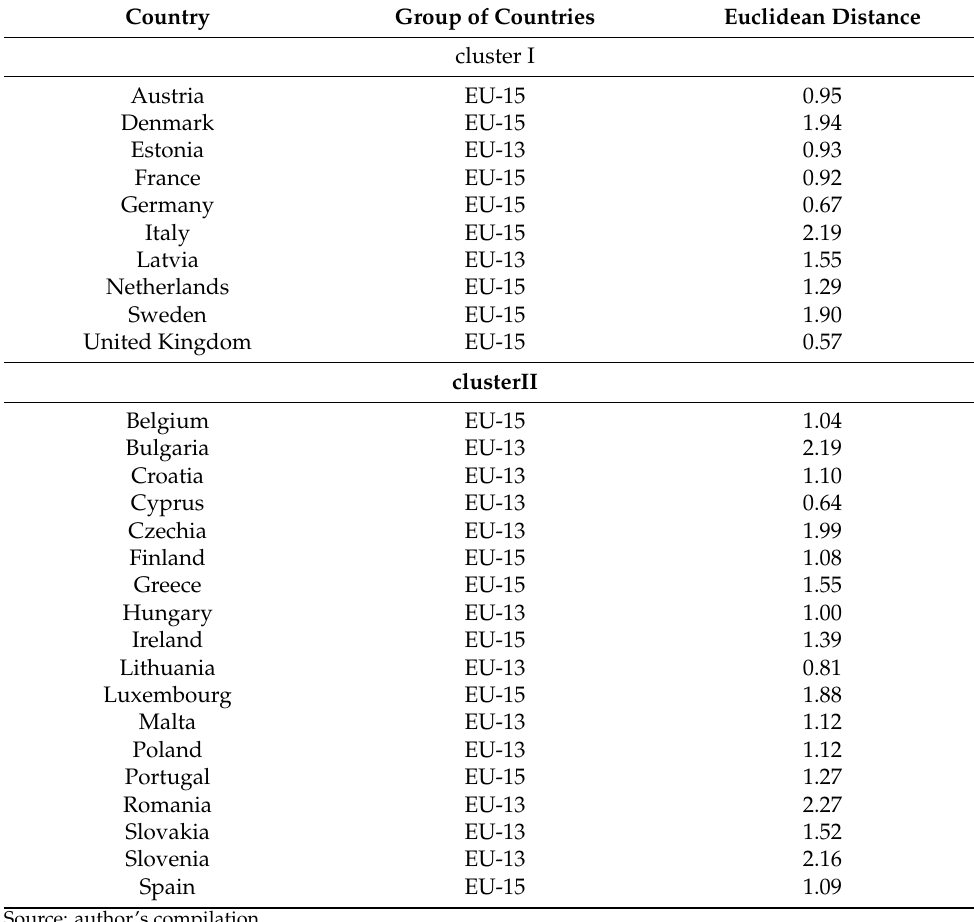
Table 11. European Union countries belonging to clusters. Country